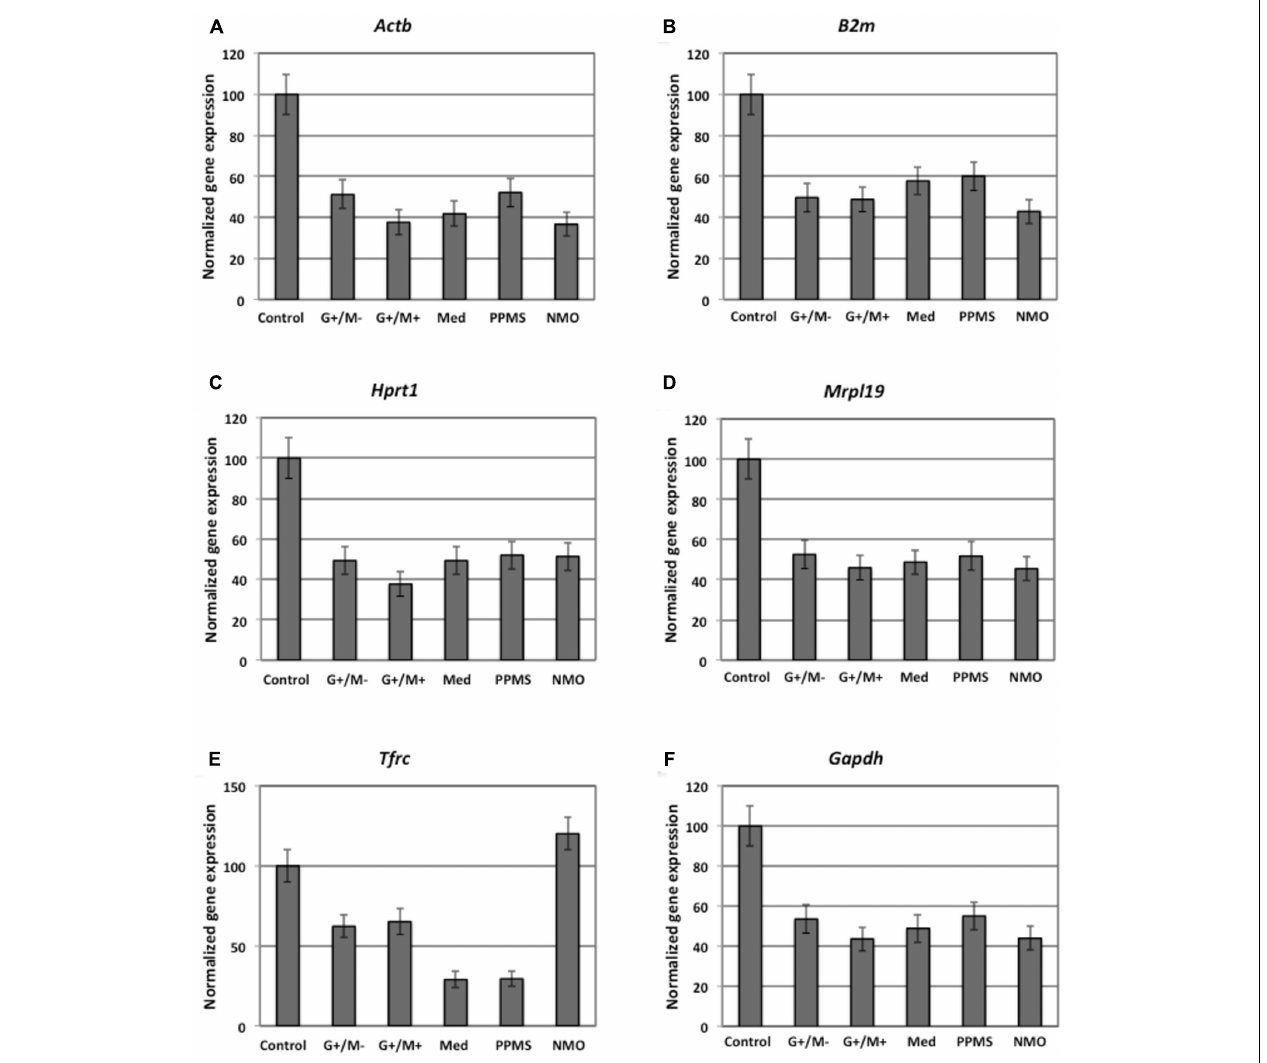
FIGURE 1 | Normalized expression of (A) ActB ; (B) B2m ; (C) Hprt ; (D) Mrpl19 ; (E) Tfrc ; (F) Gapdh reference genes in OPCs tested in distinct disease courses of multiple sclerosis. G + /M − and G + /M + : Inflammatory forms of relapsing remitting multiple sclerosis; Med: Medullary form; PPMS: Primary progressive multiple sclerosis; NMO: Neuromyelitis Optica; Control: Other non-inflammatory neurological diseases